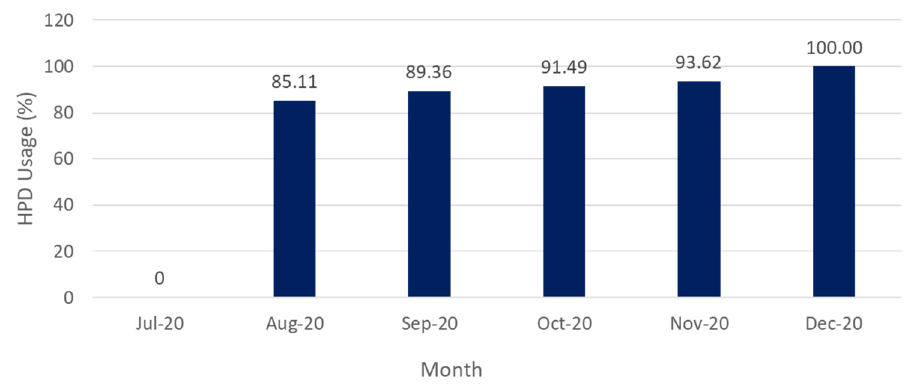
Figure 4. The trend of HPD usage among participants.